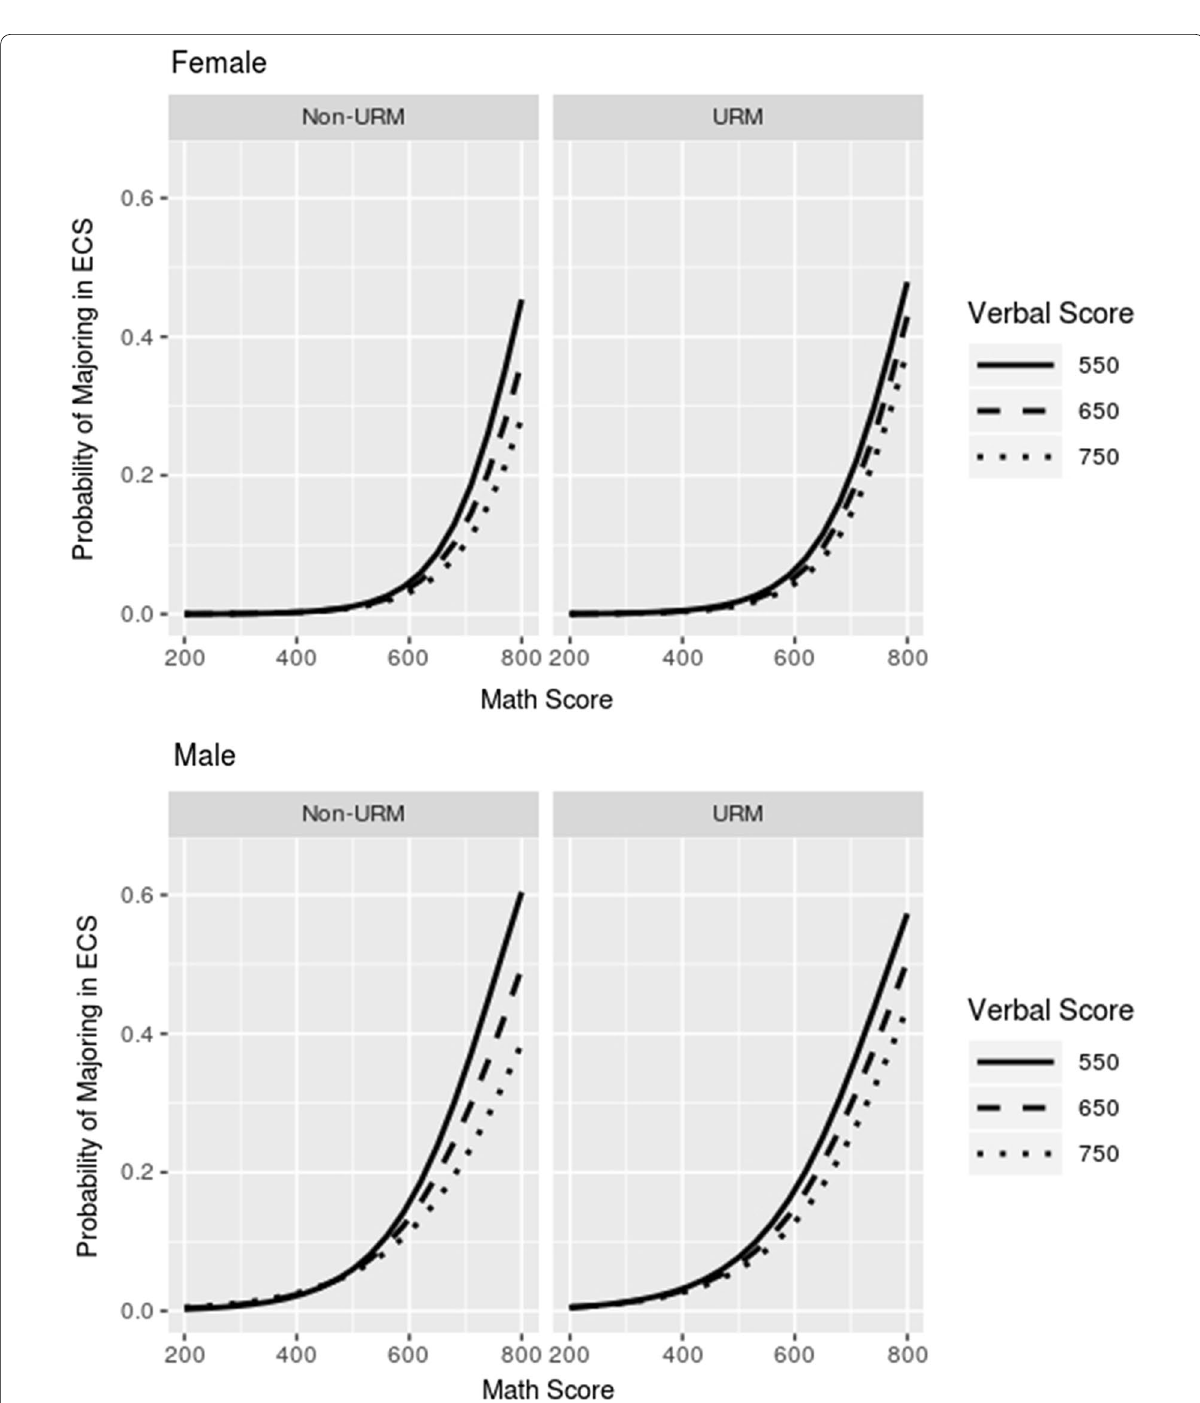
Fig. 3 The probability of male/female and URM/non-URM students enrolling in a 4-year college ECS program based on 12th grade SAT scores. The predicted probability was calculated based on the logistic regression model presented in Table